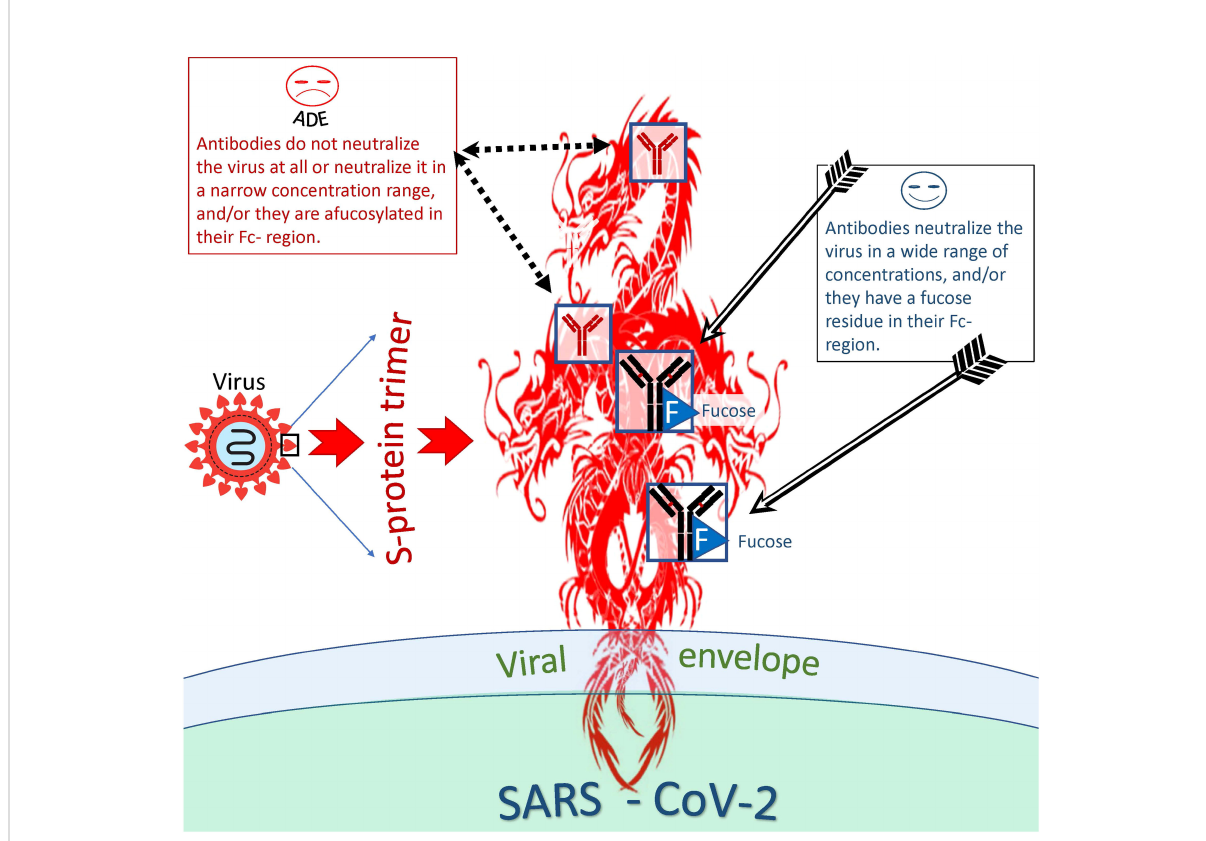
FIGURE 5 Distinction between antibodies that are more or less likely to cause ADE. Antibodies capable and incapable of causing ADEs differ both at the level of epitope recognition and by the type of antibody itself. Thus, antibodies to certain antigenic epitopes are more prone to cause ADEs than antibodies directed at other viral epitopes. In addition, afucosylated antibodies are more likely to cause ADEs compared to fucosylated antibodies. However, even antibodies capable of inducing ADE at one concentration can neutralize the virus at another and be protective against the